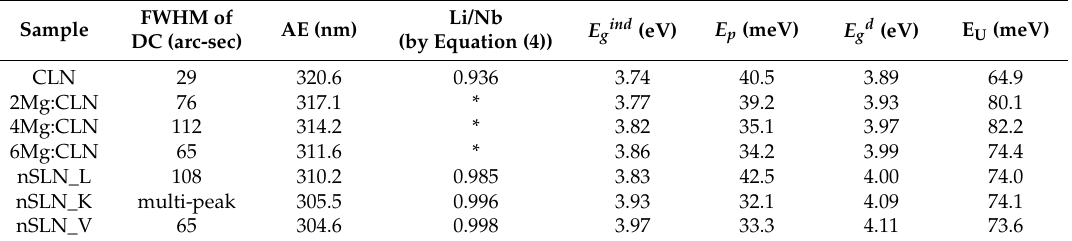
Table 2. High resolution X-ray diffraction (HRXRD) and optical parameters of the LiNbO 3 crystals prepared by different